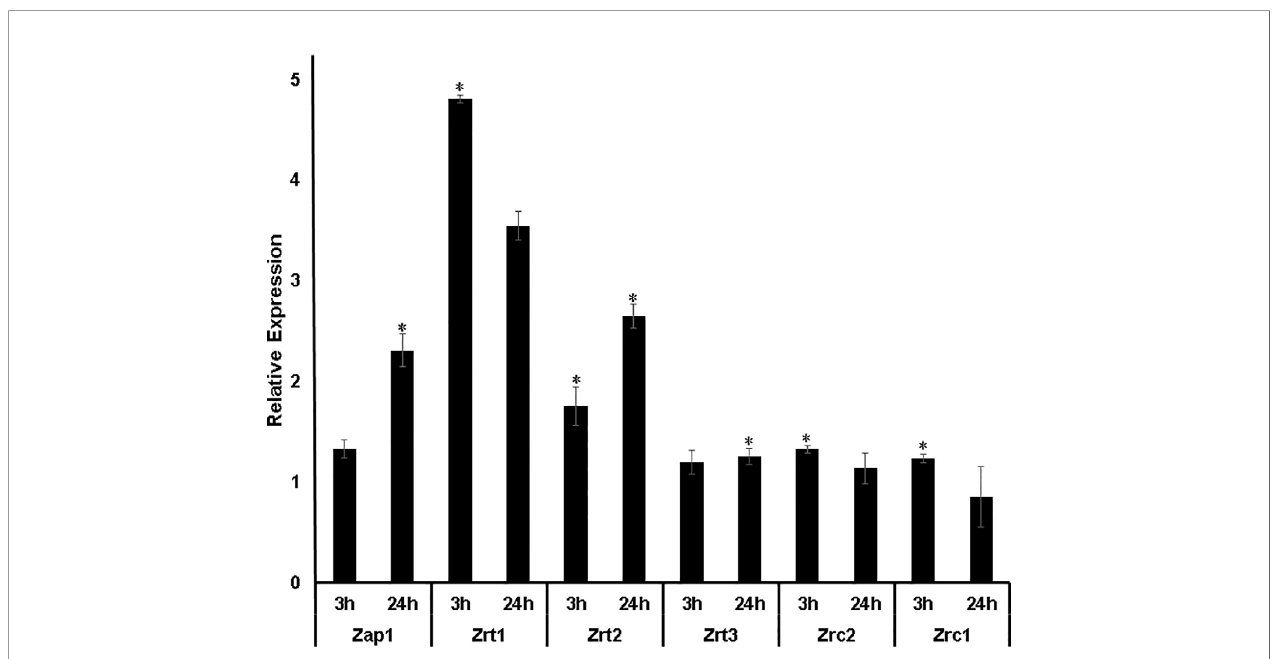
FIGURE 2 | Transcript levels of Zn homeostasis genes during Zn deprivation. ZAP1: transcription factor that regulates the expression of zinc transporters. ZRT11, ZRT2, and ZRT3: Zinc carriers of the ZIP family. ZRC1 and ZRC2: Zinc transporters of the CDF family. The DTPA transcript levels were normalized against the transcript levels of control condition. Transcriptional levels of Zn-related genes were measured in biological triplicates. *: p -value ≤